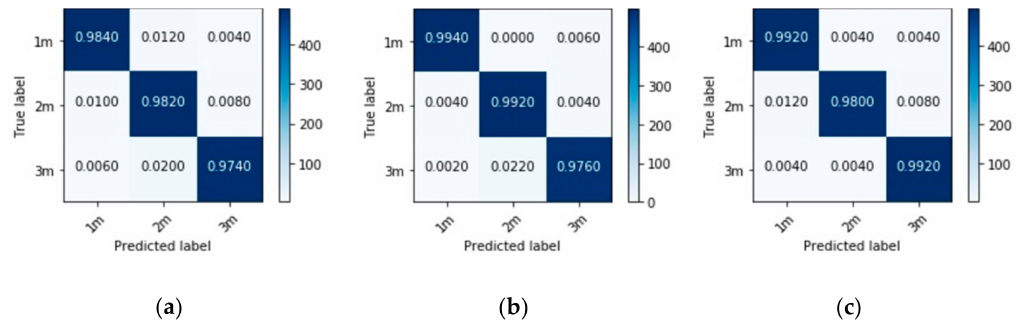
Figure 9. Confusion matrices showing the performances of models trained and tested separately in ( a ) Room 1; ( b ) Room 2; and ( c ) Room